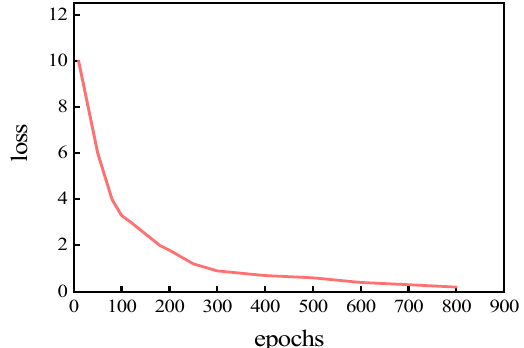
Figure 4. Iteration error of GA-BP neural network model.